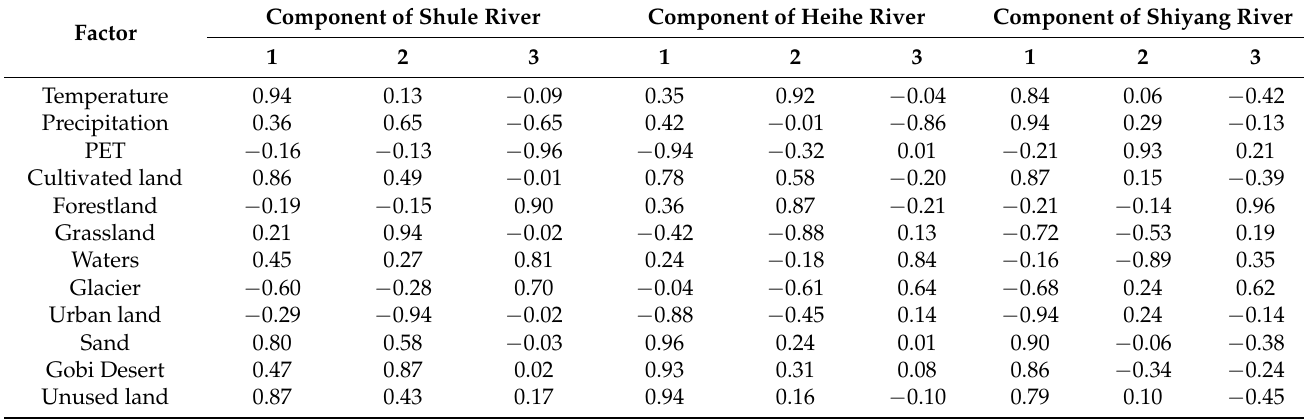
Table 5. Component matrix after